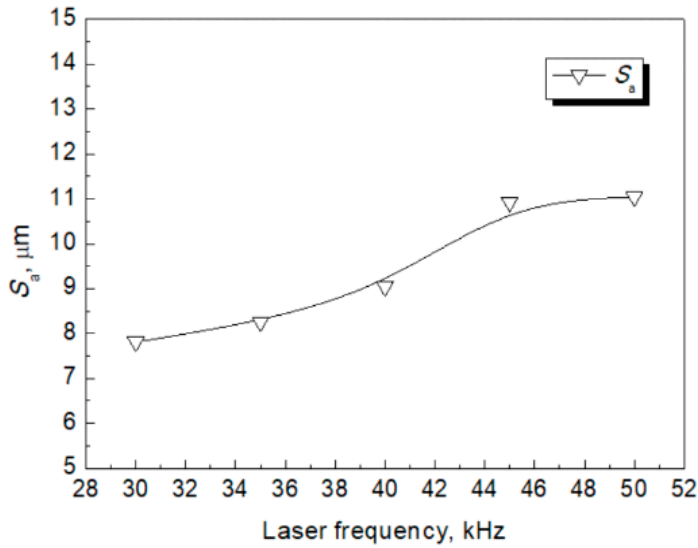
Figure 6. Surface roughness after laser milling at different pulse frequencies.